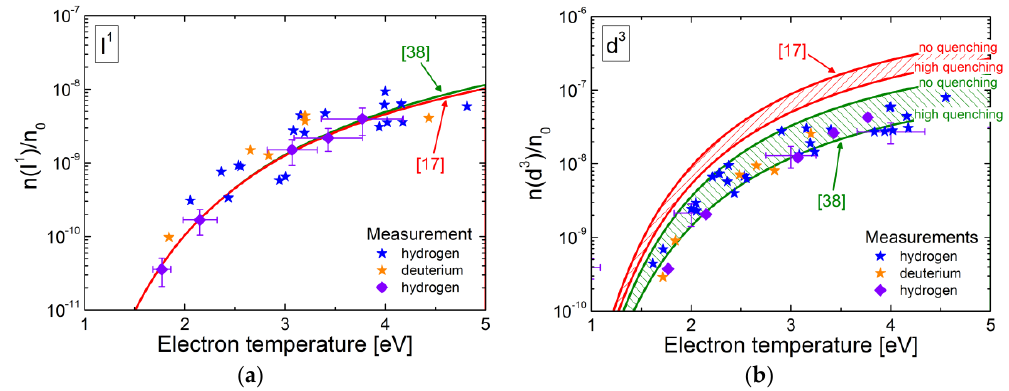
Figure 10. Comparison of population densities (normalized to the molecular ground state density) calculated by the Yacora corona model for H 2 with measurements taken in an ionizing plasma: ( a ) excited state I 1 ; ( b ) excited state d 3 .